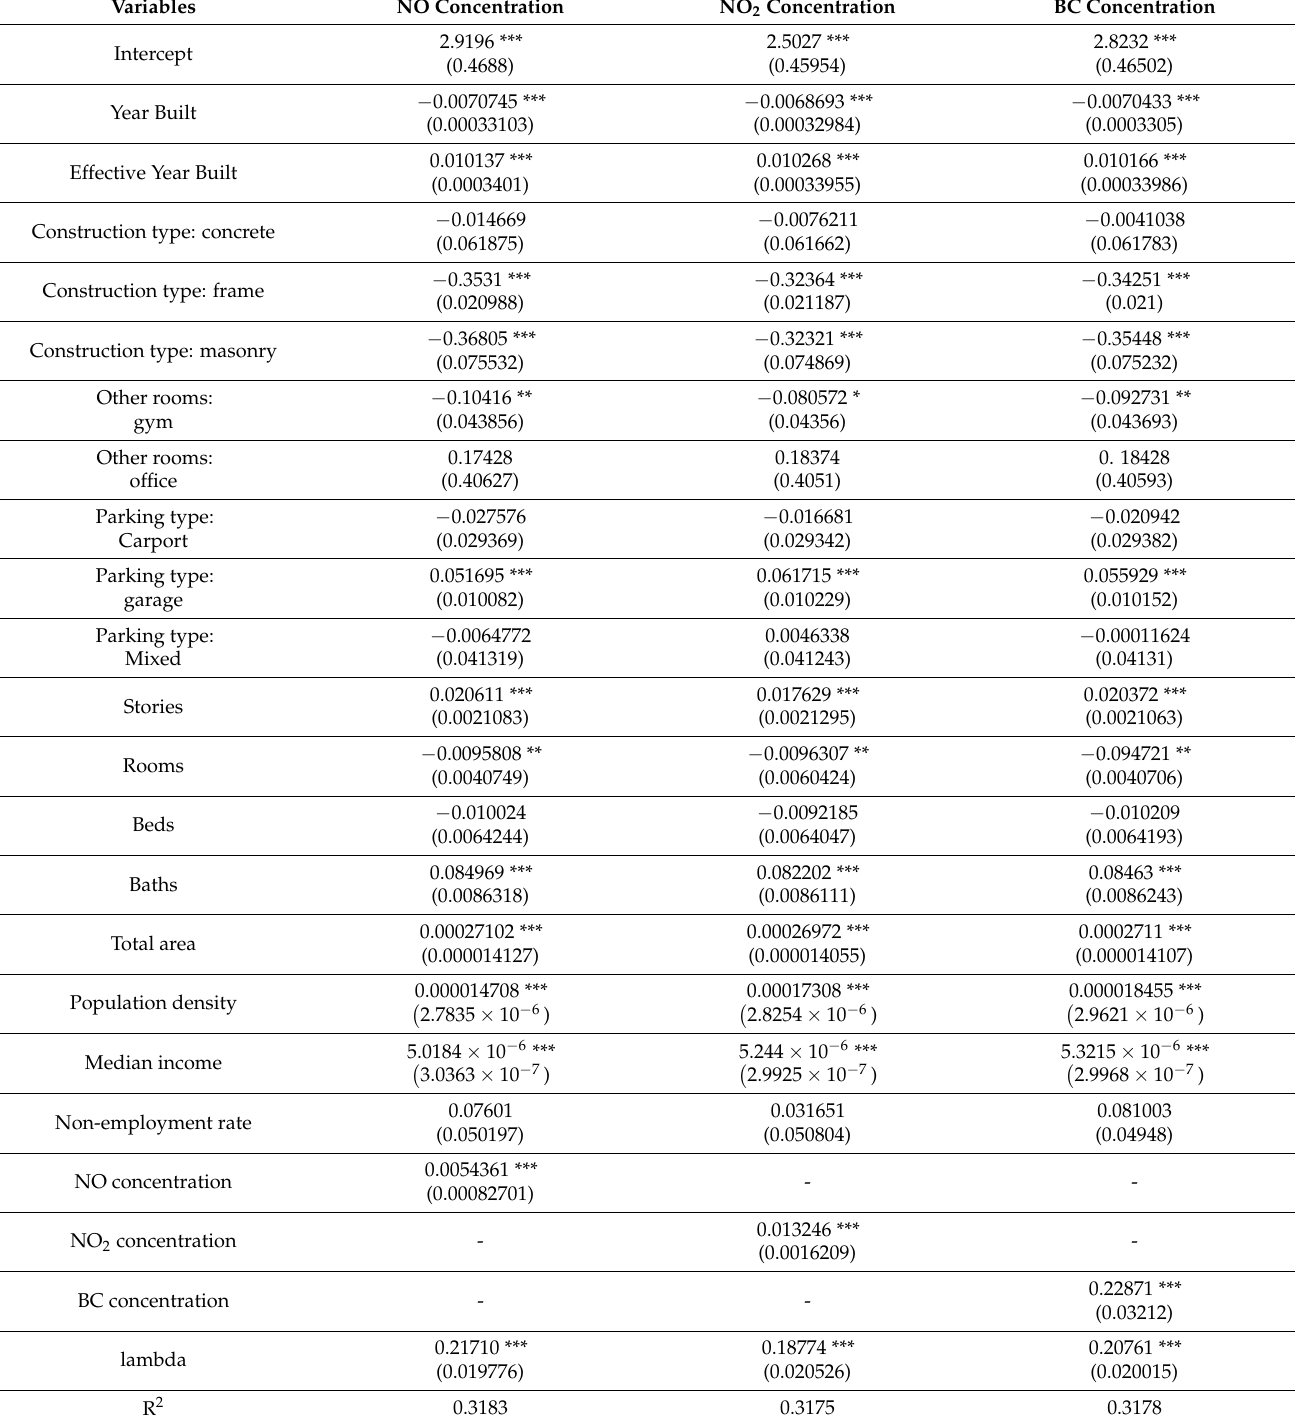
Table 3. Results of models with different pollutants a